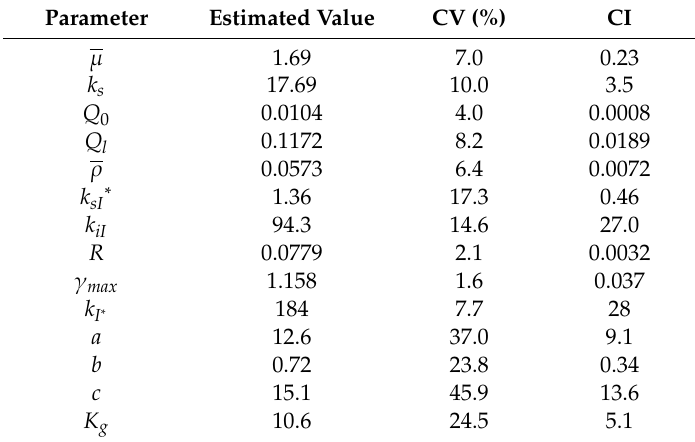
Figure 3. Experimental data (with 95% error bars) and model prediction for run 9. Table 3. Estimated parameters corresponding to Scenedesmus obliquus (physical units are defined in Table